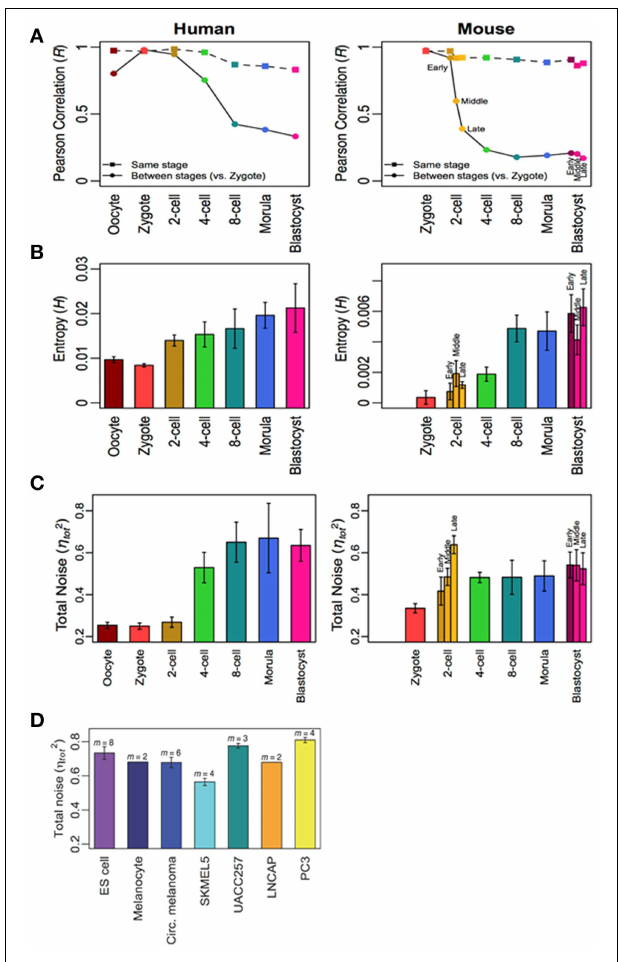
FIGURE 1 | Increasing transcriptome-wide disorder for human and mouse development cells. (A) Pearson correlation, (B) Shannon entropy, and (C) noise from oocyte to blastocysts indicate increasing disorder which stabilizes, and is similar to other differentiated and cancer cells (D) . Figure adapted from Piras et al.